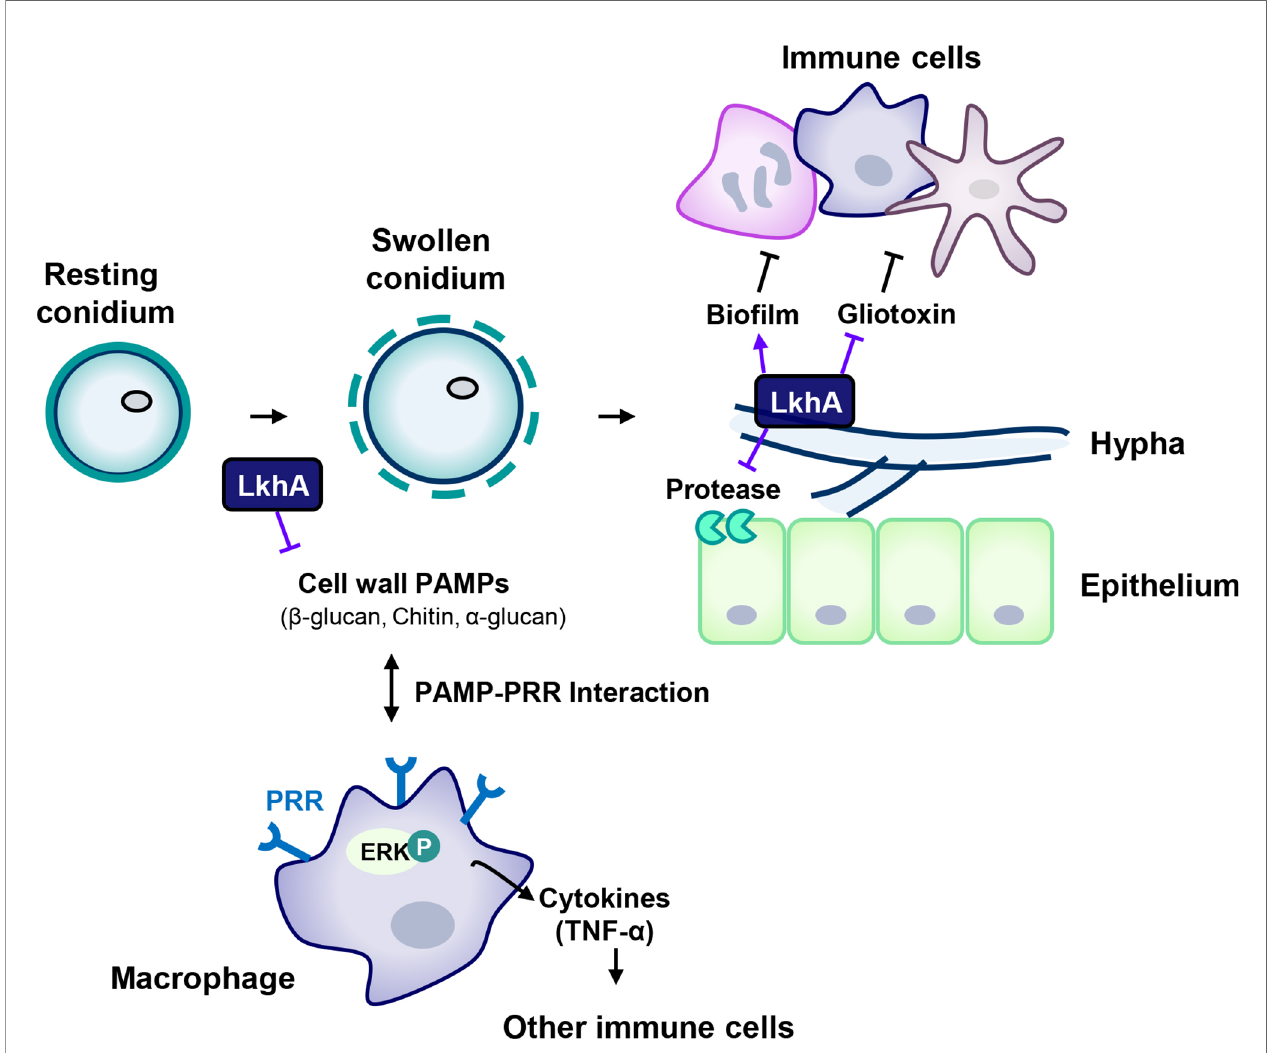
FIGURE 8 | Proposed model for the involvement of LAMMER kinase in the interaction between A. fumigatus and immune cells. The composition of the cell wall continuously changes during the life cycle of A. fumigatus . The resting conidia fi rst come into contact with host epithelial cells. When conidia swell, the outer layer (melanin and hydrophobins) is removed, uncovering the inner cell wall, which is mainly composed of glucan, chitin, and GM. LkhA regulates the transcription of genes for cell wall components and hydrophobins, which affects PAMP-PRR interactions in alveolar macrophages. This interaction mediates ERK signaling and stimulates the production of the proin fl ammatory cytokine TNF- a , which can promote the activation and proliferation of T cells. Hyphae differ in cell wall composition. The cell wall molecule GAG is secreted from hyphae and is present in the bio fi lm. The adhesion ability of A. fumigatus to the cell surface is important for virulence. LkhA is required for bio fi lm formation by modulating gene expression. During its growth, A. fumigatus produces GT, which is toxic to host cells. LkhA represses the expression of GT clustered genes and thus the production of GT. A. fumigatus also produces proteases to obtain nutrients by degrading macromolecules in the host environment. LkhA negatively regulates the expression of gene(s) for alkaline proteases and thus protease production. The virulence of A. fumigatus in the T cell- de fi cient zebra fi sh larva model was reduced by the loss of lkhA